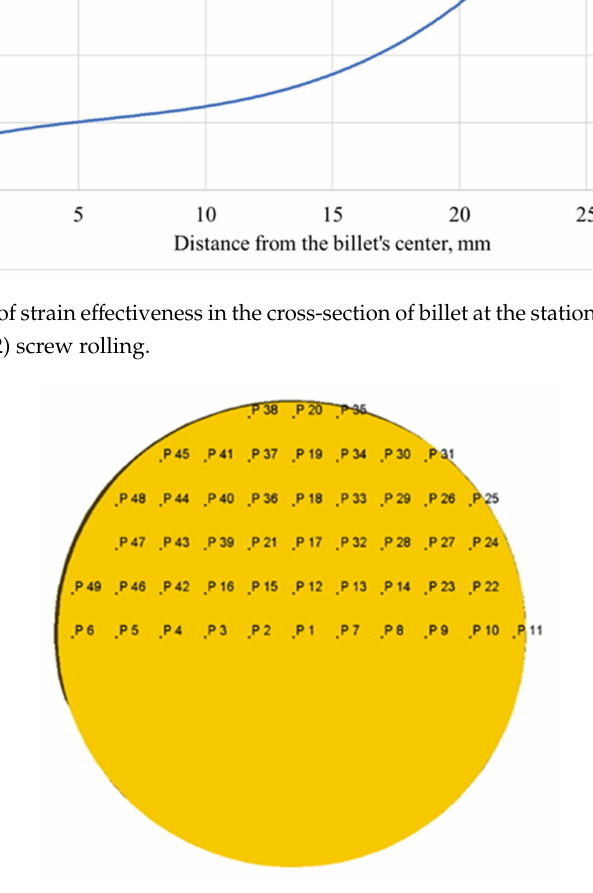
Figure 5. Points in the cross-section of the billet at the stationary stage of screw rolling for which the strain e ff ective values were calculated due to computer